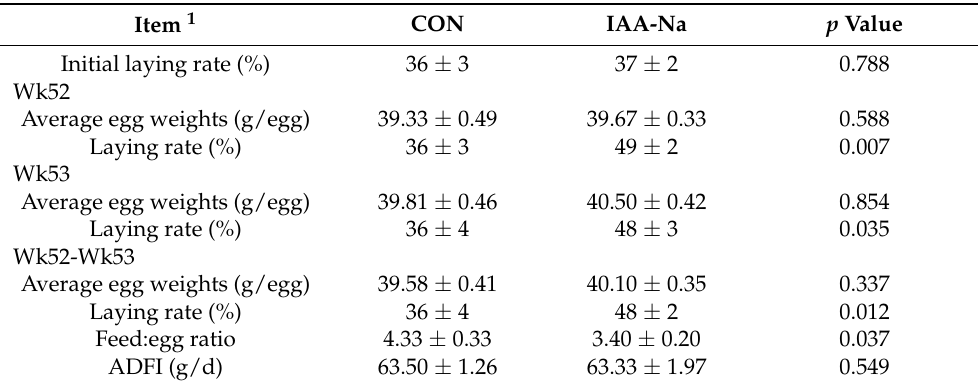
Table 2. Effect of dietary indole-3-acetate sodium (IAA-Na) supplementation on the laying perfor- mance in Danzhou chickens.